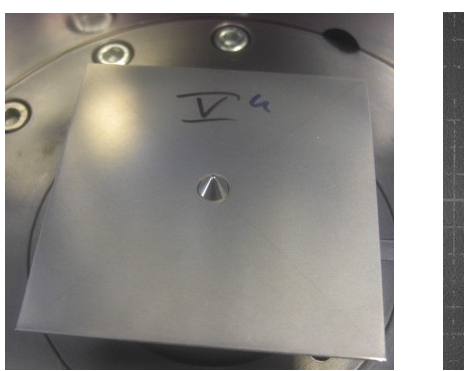
Figure 2. ( a ) Die tool used for the hole-expansion test; and ( b ) the final deformed